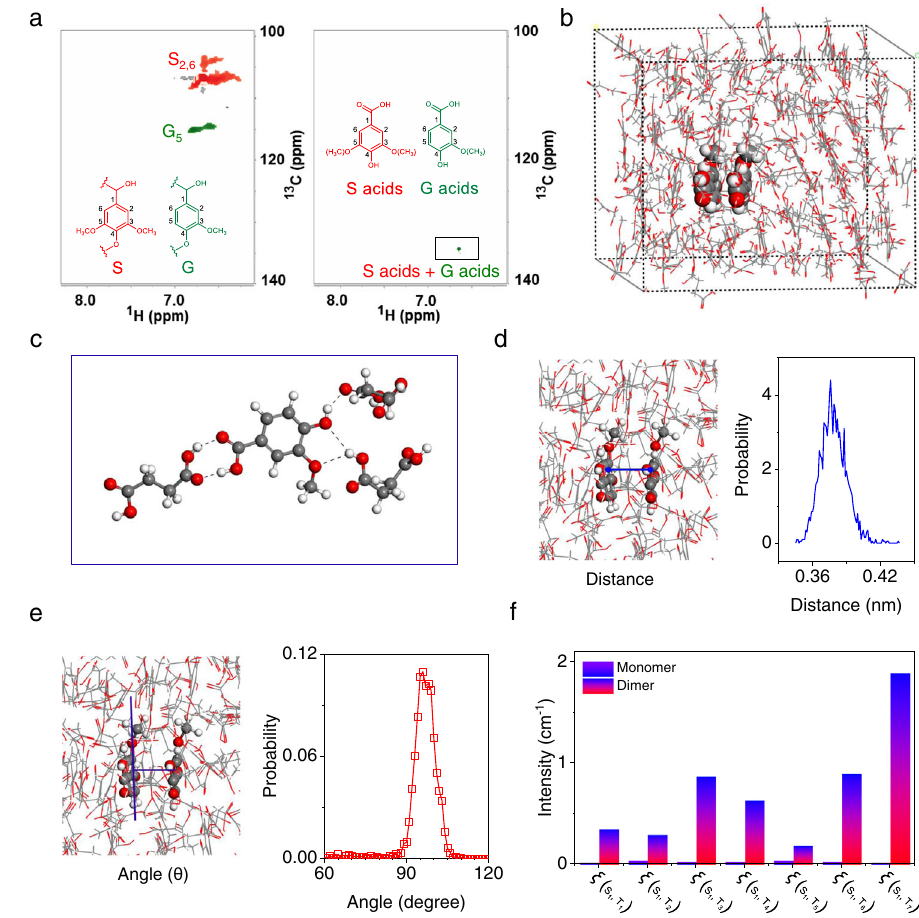
Fig.3|MechanismofafterglowRTPofOL.a 2DHSQCNMRoflignin(left)andOL (right) in the aromatic region. b and c , Simulation of molecular interactions between model aromatic acids and fatty acids in OL. d Center-center distance between adjacent aromatic molecules in OL. e , Relative orientation of two